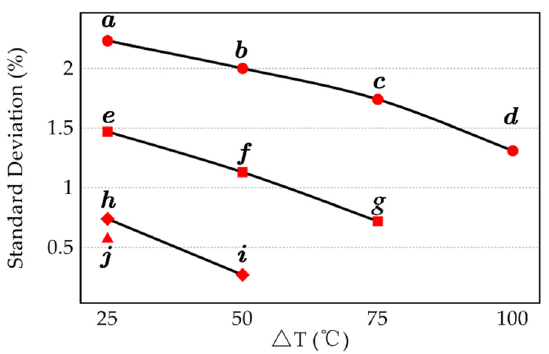
Figure 6. Relationship between temperature difference and standard deviation for the ten irradiation combinations.